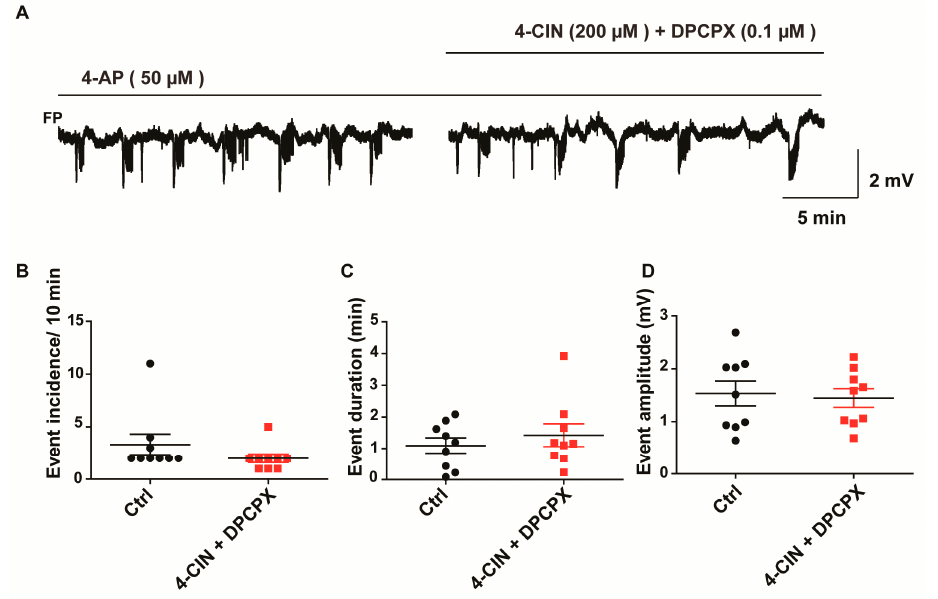
Figure 5. Dependence of the anti-seizure effect of MCT inhibition on the activation of A1 receptors. ( A ) Application of the A1 antagonist 8-Cyclopentyl-1,3-dipropylxanthine (DPCPX) in parallel with 4-CIN partially reversed the effect of MCT inhibitor on SLE ( B ) incidence ( C ) duration ( D ) amplitude. Variables are given on the Y -axis, categories of treatment on the X -axis. Each dot represents a single data point, black dots represent 50 µ M 4-aminopyridine (4-AP) application, red dots represent 5 µ M DPCPX and 50 µ M 4-AP application.